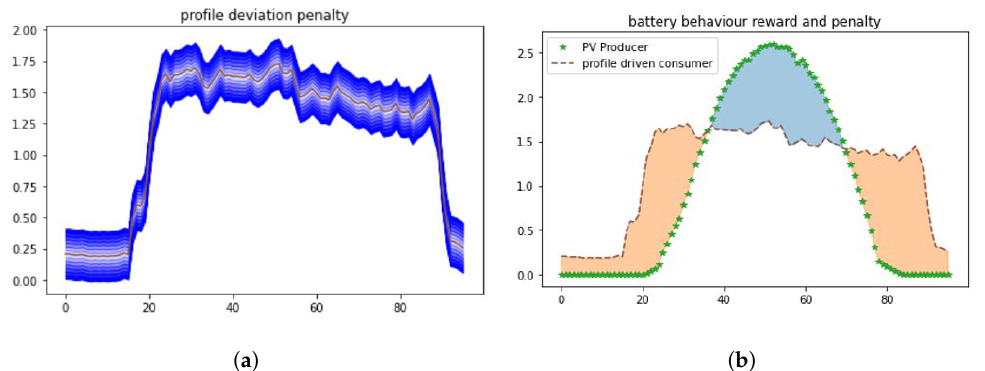
Figure 5. Reward scheme in a nutshell. ( a ) Profile deviation penalty. ( b ) Battery behaviour reward and